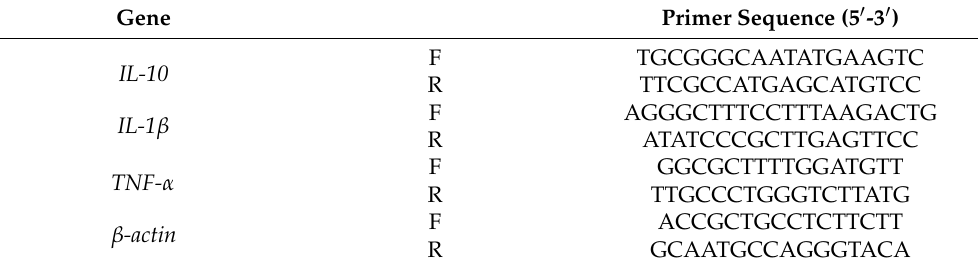
Table 2. Table 2. Sequences of RT—qPCR primers. Gene Primer Sequence (5 (cid:48) -3 (cid:48)